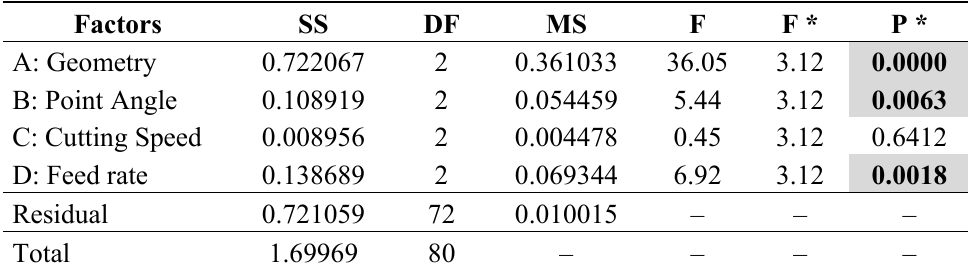
Table 5. ANOVA results for exit delamination factor.